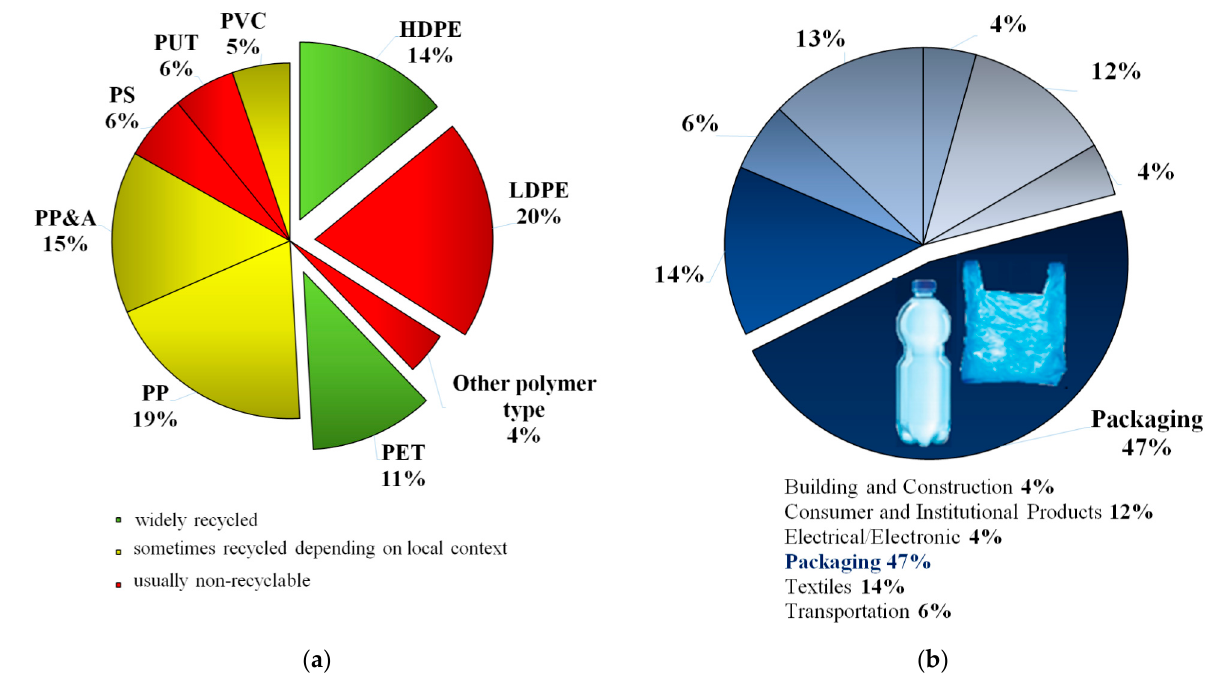
Figure 1. Plastic waste in the world (2015 production): ( a ) by polymer type, ( b ) by sectors.